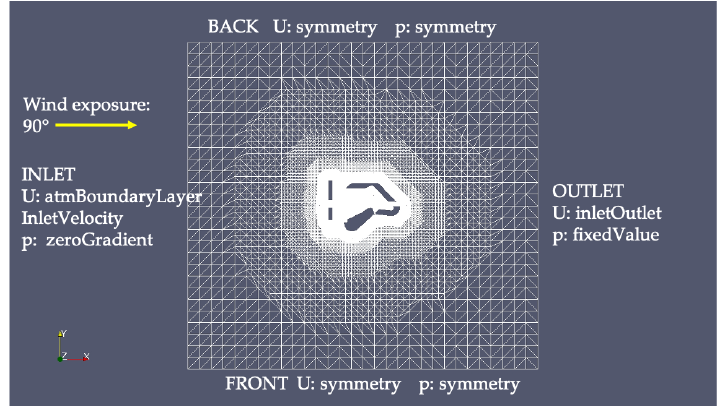
Figure 12. Boundary